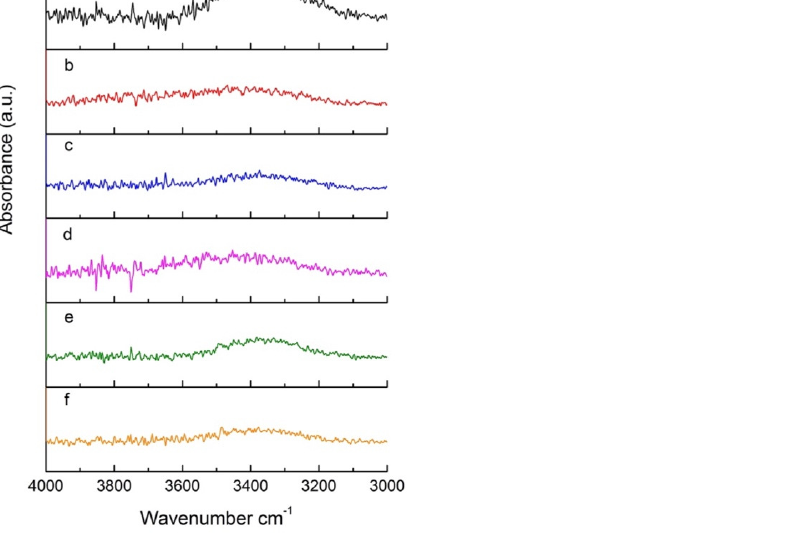
Figure 7. Section of the FTIR spectra of ( a ) untreated poplar and ( b – f ) poplar treated at reduced